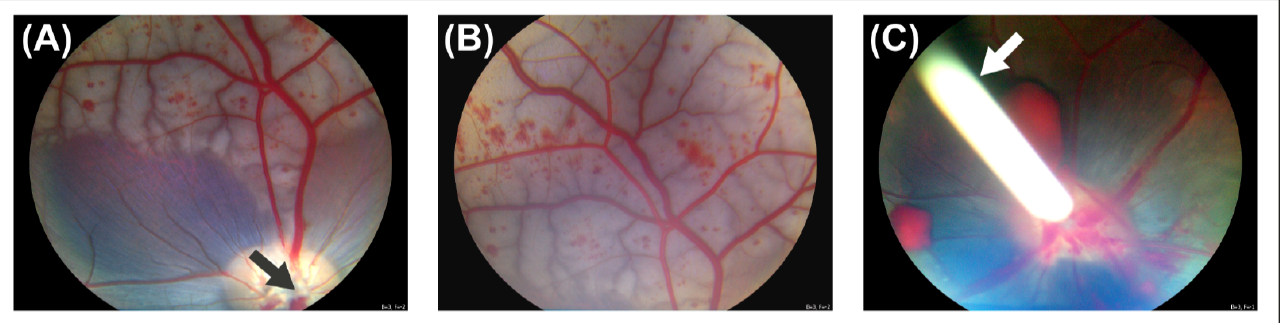
Figure 1. Funduscopic images obtained four days after induced CRVO. ( A ) Retinal hemorrhages and dilation of retinal veins are observed upstream of the site of occlusion. Black arrow: site of occlusion. ( B ) Fundus image of the peripheral retina. Multiple retinal hemorrhages are observed. ( C ) Dexamethasone (DEX) implant injected into eye with experimental CRVO. White arrow: DEX implant.